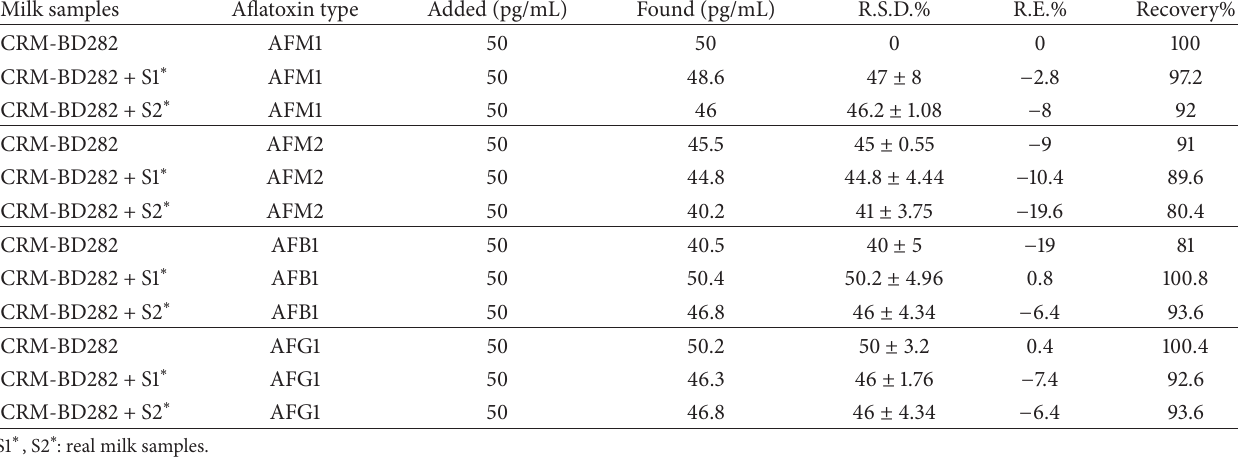
Table 4: Recovery studies of real milk sample fortified with different aflatoxins.